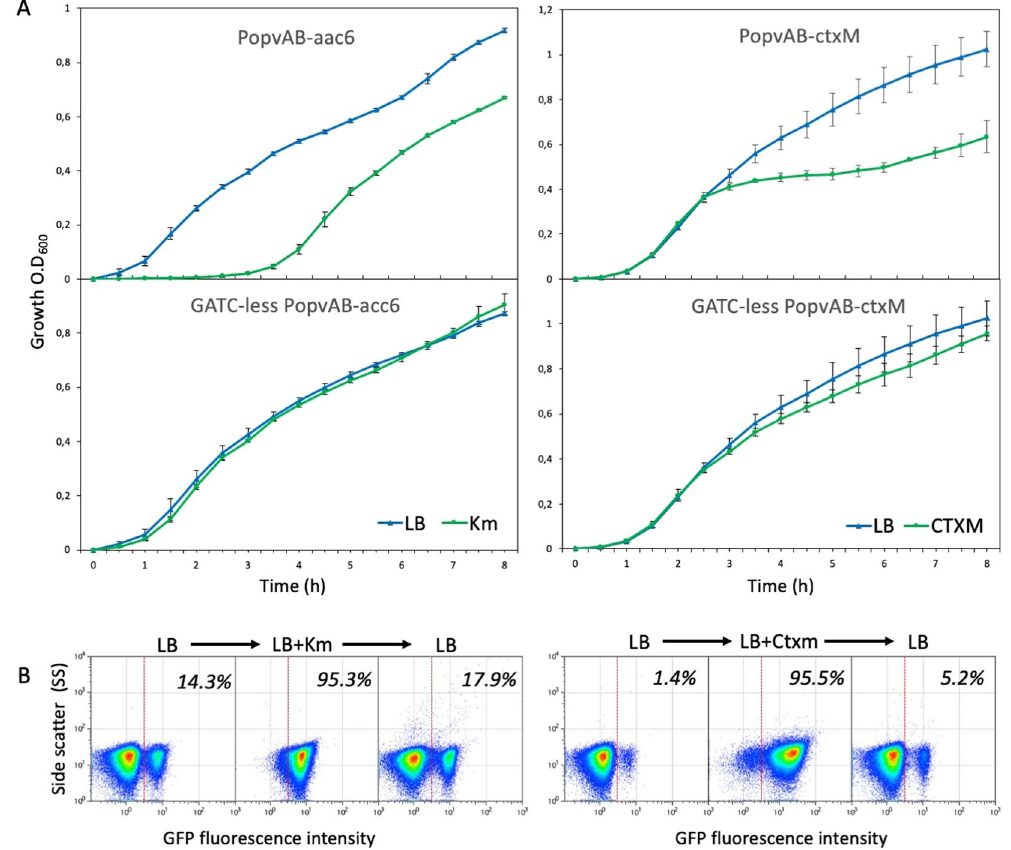
Figure 3. ( A ) Growth of strains SV9703 (P opvAB ::aac6 :: gfp ), SV9705 (P opvAB GATC-less:: aac6 :: gfp ) SV9706 (P opvAB :: ctxM :: gfp ) and SV9707 (P opvAB GATC-less:: ctxM :: gfp ) in LB and in LB + antibiotic (kanamycin and cefotaxime, respectively). ( B ) Left: reversibility of formation of Km s and Km r subpopulations under opvAB control. Right: reversibility of formation of CtxM s and CtxM r subpopulations under opvAB